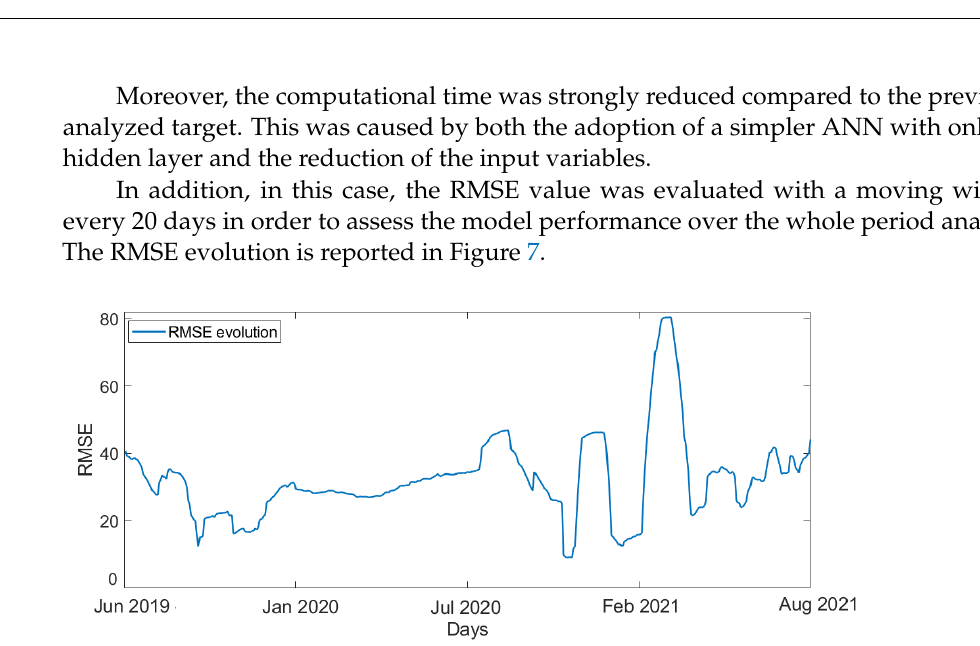
Figure 7. RMSE evolution calculated with a moving window over 20 days in terms of the model’s prediction of the steam flow rate going to the regenerator.